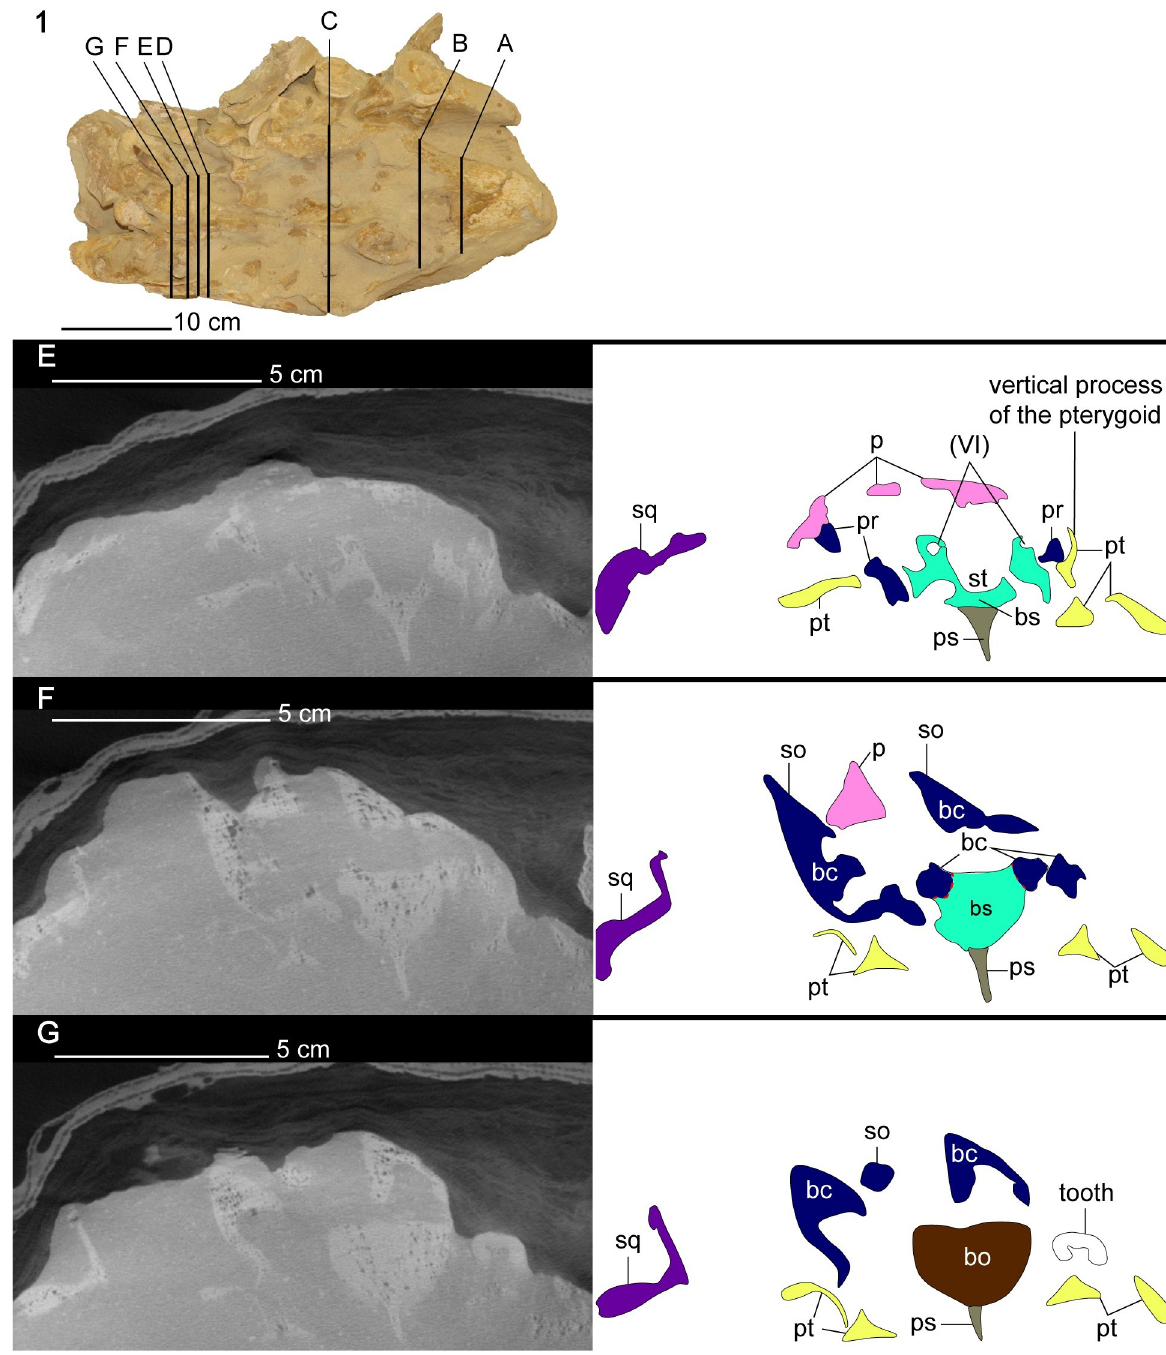
Fig 9. CT cross-section images of the cranium of Cardiocorax mukulu (MGUAN PA278). E. Section through the sella turcica exposing the abducens canal. F. Section through the mid-section of the braincase. G. Section through the posterior section of the braincase. https://doi.org/10.1371/journal.pone.0255773.g009 Postorbital . The postorbital is a triangular element that forms the posterior border of the orbit and the anterior margin of the temporal fenestra. It has a posterior process forming part of the dorsal margin of the temporal bar posterior to the orbit. The postorbital contacts the